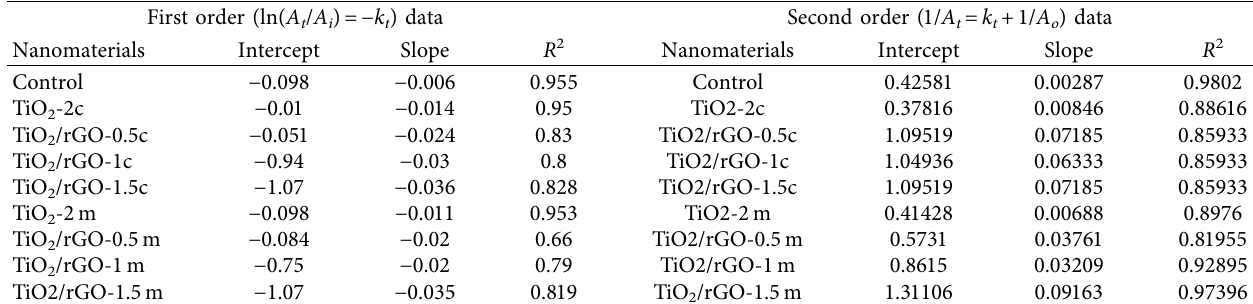
Figure 10: Pseudo-first (a) and pseudo-second (b) order kinetic models for photocatalytic degradation of MB dye using Citrus sinensis and Musa acuminate template synthesized TiO 2 NPs and TiO 2 /rGO NCs. Table 1: Calculated parameters for first and second order kinetic data